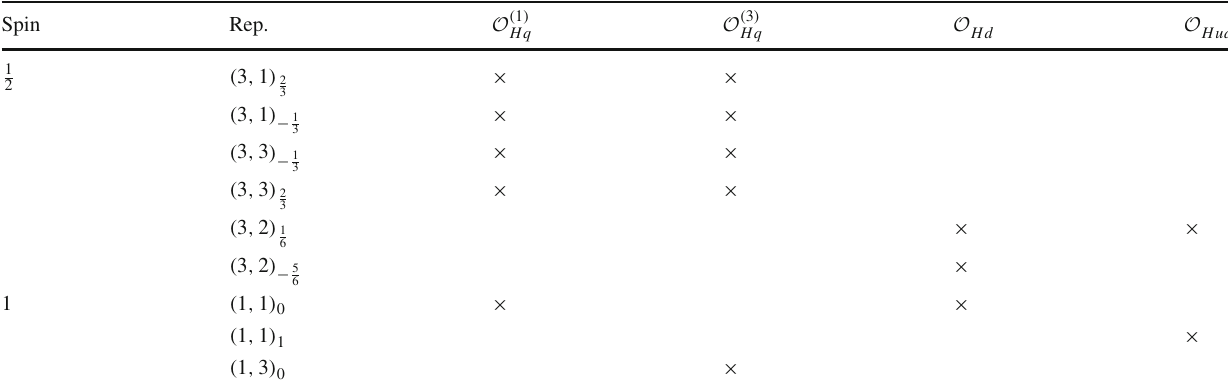
Table 4 SMEFT operators of type ψ 2 H 2 D inducing corrections to W ± and Z 0 couplings, generated by the tree-level mixing of SM fields with heavy vector-like quarks or vector fields. The second column gives the representation under G SM = SU ( 3 ) c ⊗ SU ( 2 ) L ⊗ U ( 1 ) Y Spin